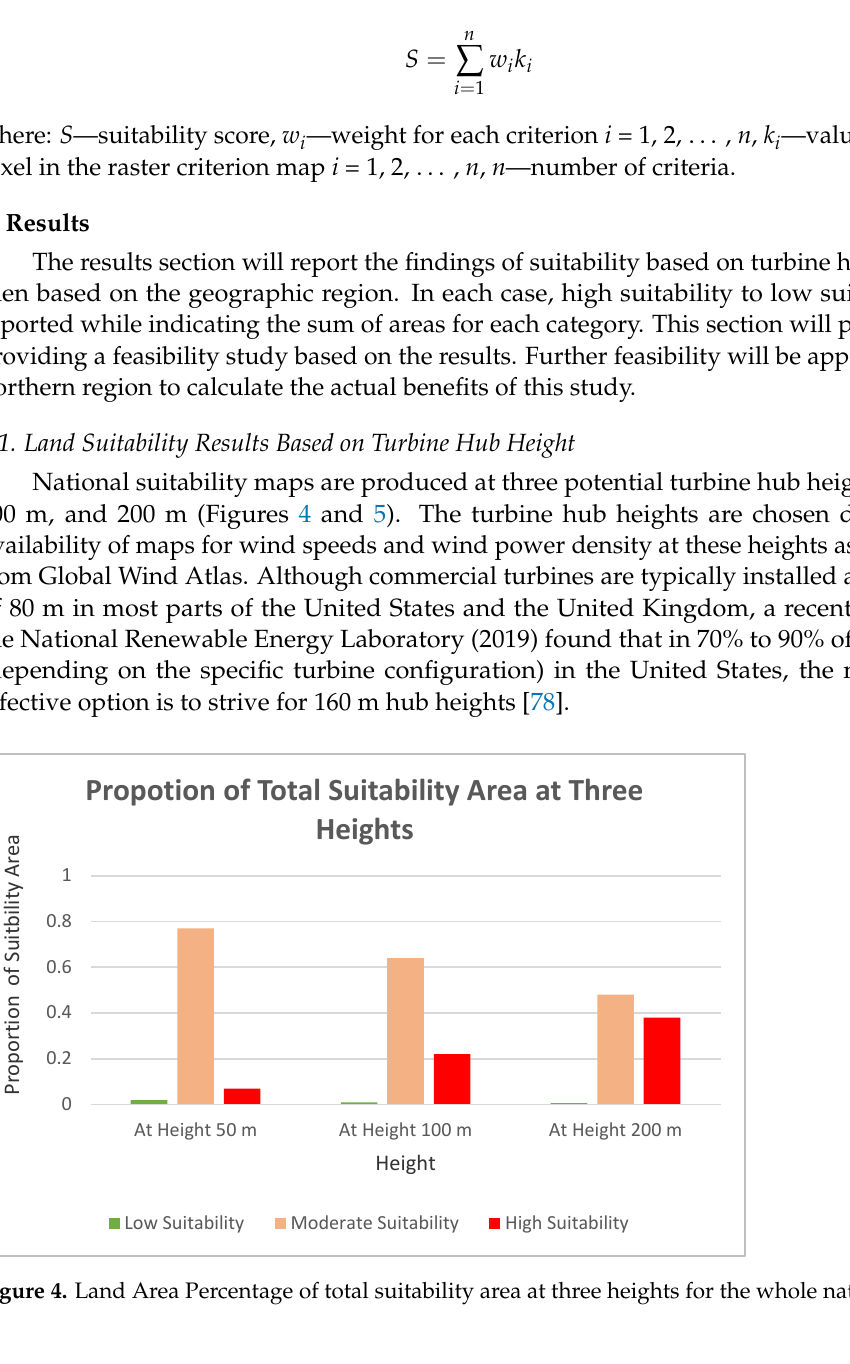
Figure 5. Final wind farm suitability locations at three heights; ( a ) 50 m, ( b ) 100 m, ( c ) 200 m. White areas are the areas excluded from the study due to restrictions on the use of wind turbine farms. 3.2. Findings Identified by Region The following three sections will demonstrate the findings of each region concerning wind farm suitability areas associated with the different wind turbine heights. It includes the Northern, Middle, and Southern Regions. 3.2.1. Northern Region At a height of 50 m, areas with high suitability in the Northern Region make up a total area of 2424.3 km 2 . Individual governorates within the region have the following